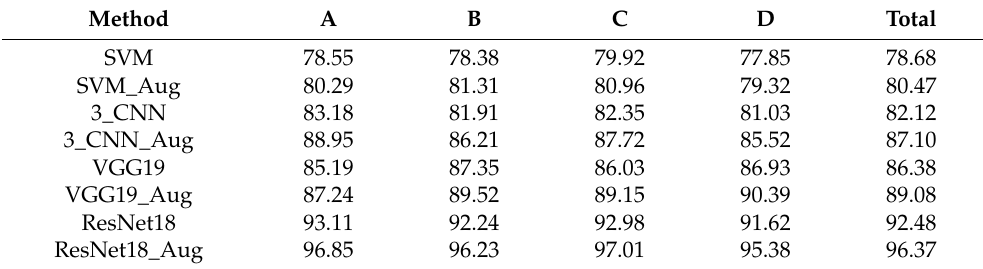
Table 2. Recognition accuracy (%) for different types of ships’ target signals with the input of the MFCC.